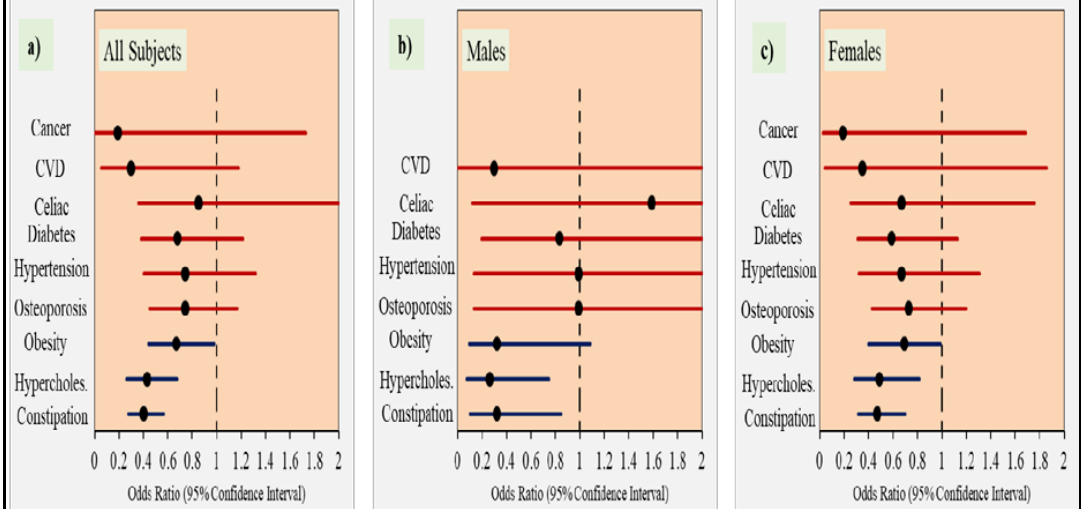
Figure 2. Odds of having the self-reported diseases in the highest quartile of DF consumption compared to lowest quartile. Note: Data are presented as O.R. (odds ratio, black dot) and 95% CI (confidence interval, horizontal line) represents the odds of having the self-reported diseases in those in the highest quartile of DF consumption (based on whether or not study participants regularly consume the listed 30 food items rich in DF) compared to those in the lowest quartile. The vertical dotted line represents the reference (lowest quartile). The data is presented for all participants ( a ), males ( b ), and females ( c ).